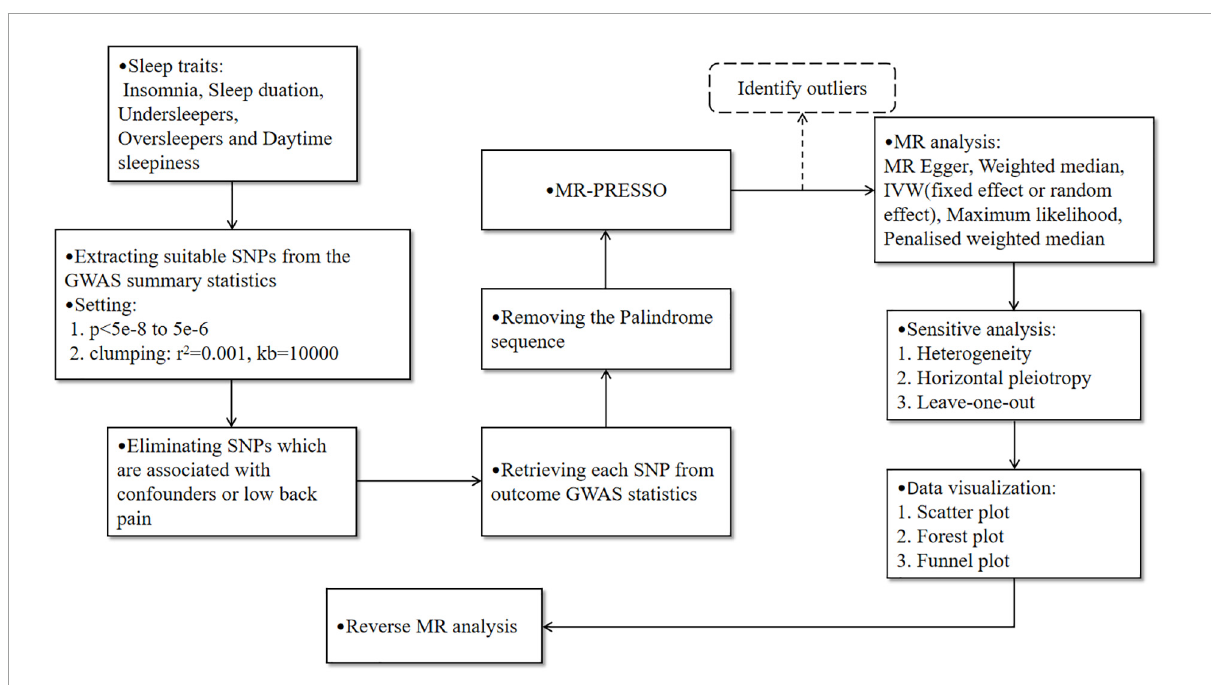
FIGURE3 The design flow chart for the Mendelian randomization (MR) study. The dotted line indicates that the outliers may be eliminated after identification by MR-PRESSO, which needs to be judged based on the stability of the results before and after